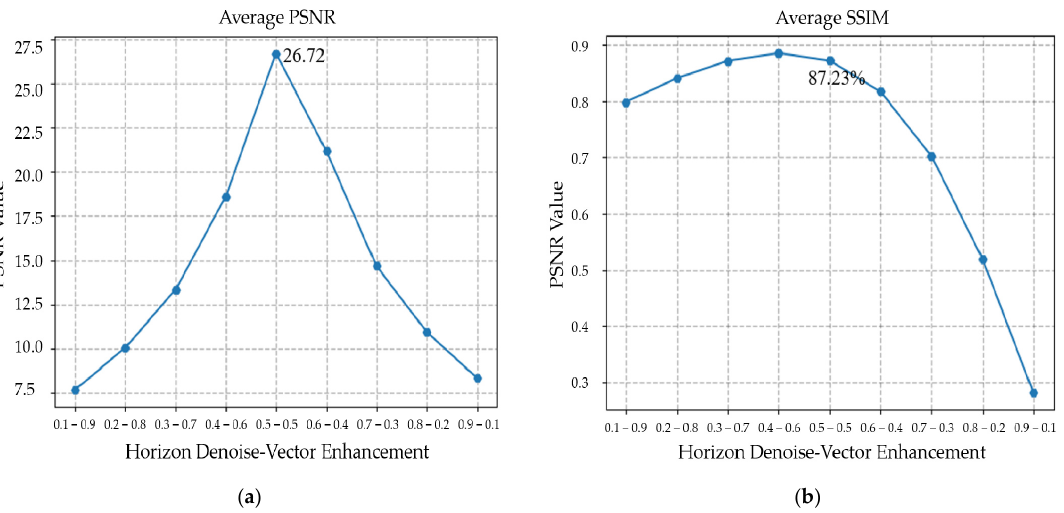
Figure 5. The average PSNR and average SSIM: ( a ) The average PSNR; ( b ) The average SSIM. The ground penetrating radar images after processing are shown in Figure 6. The high-frequency interference noises at the bottom are significantly reduced, the horizontal standing waves are reduced, and the effective signals at the depth are enhanced. In order to further suppress the background noises, the image contrast at high gray values is enhanced by gamma transformation. In order to observe the grayscale distribution in the image more intuitively in the experiment, the color distribution is divided into 128 color bins and the grayscale histogram distribution of the images is calculated as shown in Figure 7. The highlight feature of abnormal information means that abnormal information is mostly distributed in higher gray levels in grayscale images. As shown in the second column, (b), (f), (j), and (n) in Figure 7, the grayscale histogram distribution of the image before Gamma transformation is relatively uniform, which means that the abnormal information of interest is not obvious compared with the background. The background information is too complex to extract effective information. After the Gamma transformation with a coefficient of 5, the overall brightness of the images becomes dark, as shown in the third column, (c), (g), (k), and (o) of Figure 7, and the grayscale histogram of the fourth column, (d), (h), (l), and (p) of Figure 7, shows that in the original images most of the low gray value points in the images are adjusted to 0 after Gamma transformation, and the more complex and low gray value background is suppressed so that the abnormal high brightness regions are visually highlighted. Excessive Gamma transform coefficients may cause some effective signals to be misjudged as background signals and adjusted to zero, and the overall picture is darker, resulting in poor visual effect, which is not conducive to the extraction and construction of visual attention features in later steps. The experimental results show that the suppression effect on the background noises of the GPR images is more obvious when the Gamma coefficient is 5, and the loss of effective information is relatively